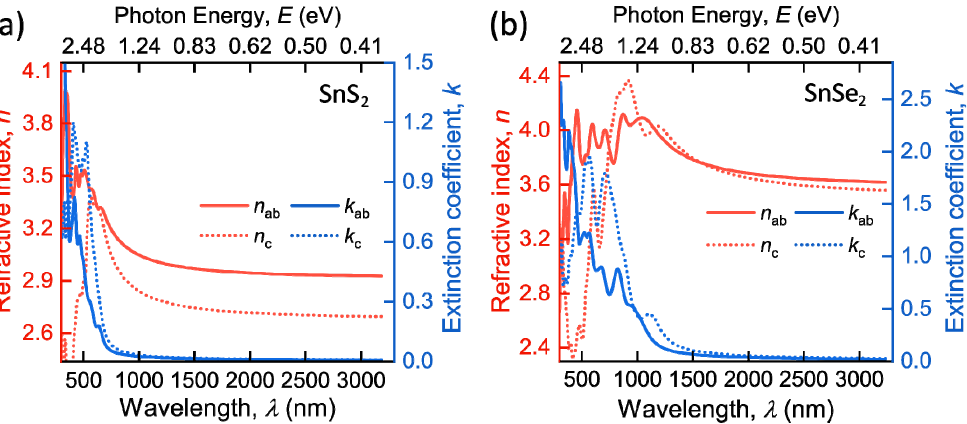
Figure 4. First-principle calculations of SnS 2 and SnSe 2 . Optical constants for ( a ) SnS 2 and ( b ) SnSe 2 , including in-plane n ab , k ab and out-of-plane n c , k c parts of dielectric tensor. In the light of the rapid development of nonlinear optical devices based on SnS 2 and SnSe 2 [36,37,61], we also measured their nonlinear optical response (Figure 5). Specifically, we measured the second harmonic generation (SHG) in transmission geometry using 150 fs SHG power dependence with the expected slope of 2 (2.01 ± 0.02 for SnS 2 and 2.02 ± 0.04 effects. SHG spectra of SnS 2 and SnSe 2 are shown in Figure 5b. For SnSe 2 , SHG resonance